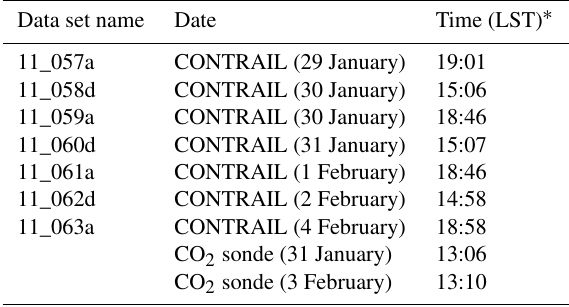
Table 1. CONTRAIL flight data near to the CO 2 sonde measure- ments on 31 January and 3 February 2011.